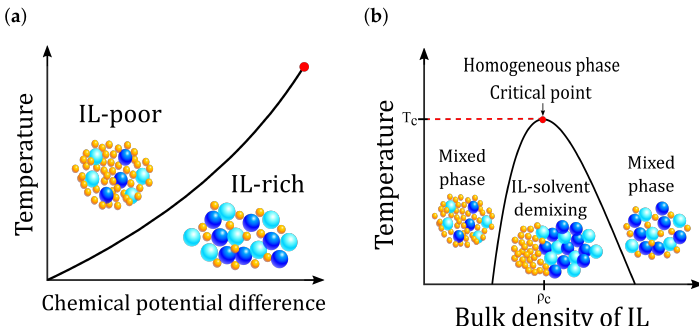
Figure 2. Schemes of an IL-solvent mixture phase diagrams. ( a ) Scheme of an IL-solvent mixture phase diagram in the temperature-chemical potential plane. Below T c (shown by the red circle), two phases coexist along a saturation chemical potential µ sat . One phase is rich in IL, and the other phase is rich in the solvent. Light blue spheres denote cations, while blue spheres denote anions. Solvent molecules are denoted by yellow spheres. ( b ) Scheme of an IL-solvent mixture phase diagram in the temperature-concentration plane. Above the critical temperature T c , the system is homogeneous for any temperature and bulk composition of IL. Below T c , the mixture phase separates into one phase rich in IL and the other phase one rich in the solvent. The critical composition of IL is denoted by ρ c